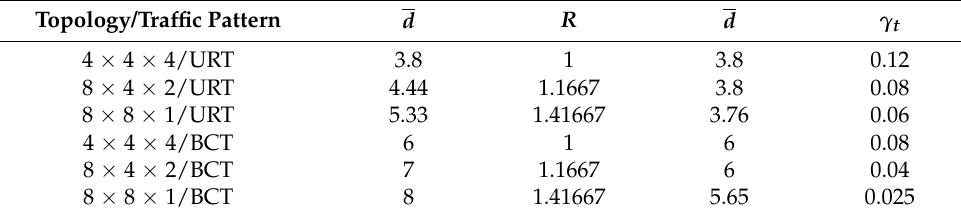
Table 3. Relationship between average distance, regularity and saturation injection rate. Topology/Traffic